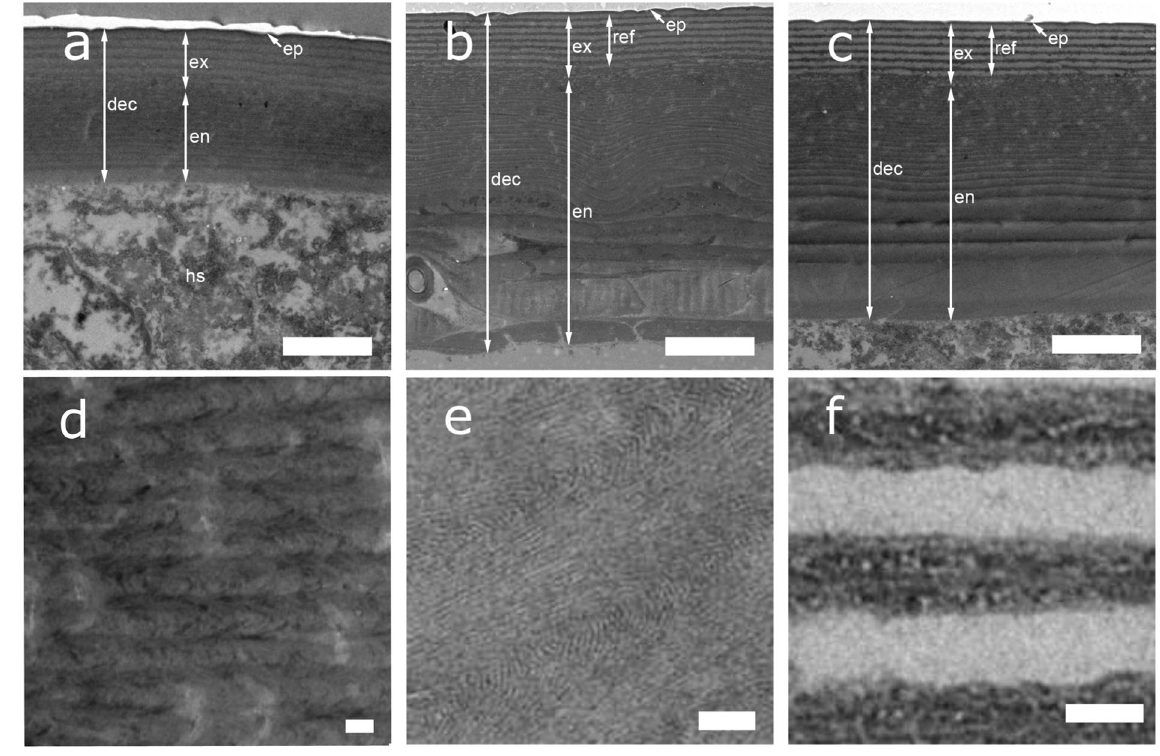
Figure 3. Figure 3 TEM sections of the developing dorsal elytral cuticle (“dec” in the figure), which illustrate the development of the endocuticle (“en”), exocuticle (“ex”), and epicuticle (“ep”). The cuticle after ecdysis (Stage 4: ( a )) is considerably thinner than in the later stages 5 and 6 ( b , c ). The hemolymph space (“hs”) is visibile underneath the elytra. In ( b ), the young imago shows a more defined exocuticular multilayer reflector (“ref”) and a thicker endocuticle. The old imago, ( c ) exhibits a fully-formed cuticle. At higher magnification, it is possible to appreciate the structure of the inner exocuticle in ( d , e ) and the alternating fibril arrangement in the multilayer reflector in ( f ) for the fully formed imago. Scale bar: 2 μ m for ( a – c ), and 100 nm for ( d – f